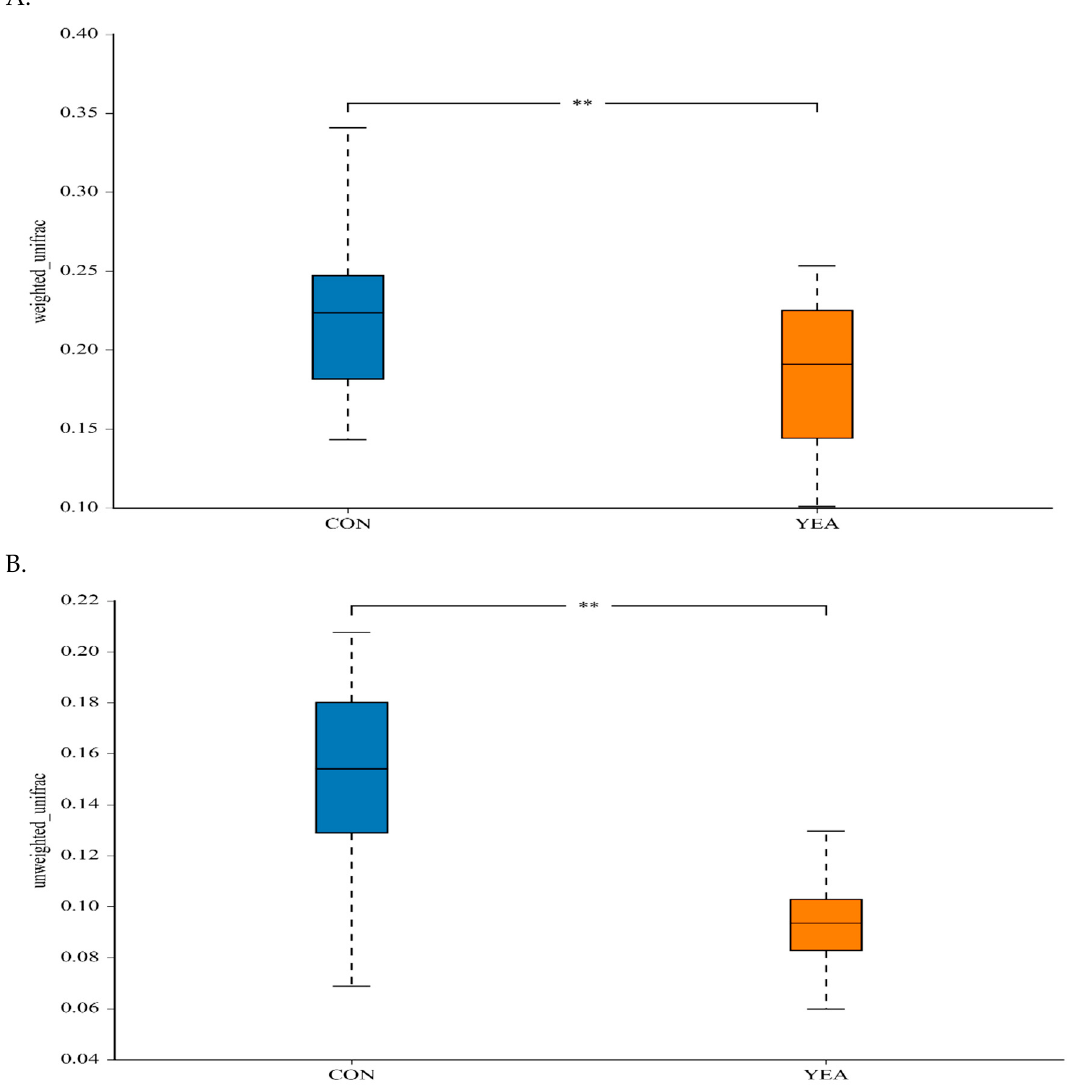
Figure 1. ( A ) Between-sample ( β ) diversity indices for the weighted and ( B ) unweighted uniFrac distances of rumen samples from beef steers fed no (control; CON) or 15 g/d of live yeast product (YEA; PMI, Arden Hills, MN, USA), ** p < 0.05.